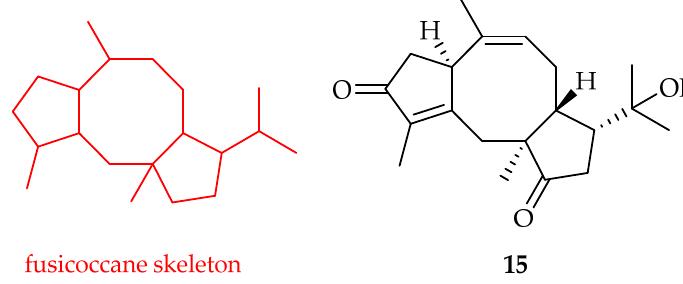
Figure 7. Structure of fusicoccane skeleton and compound 15 [14].